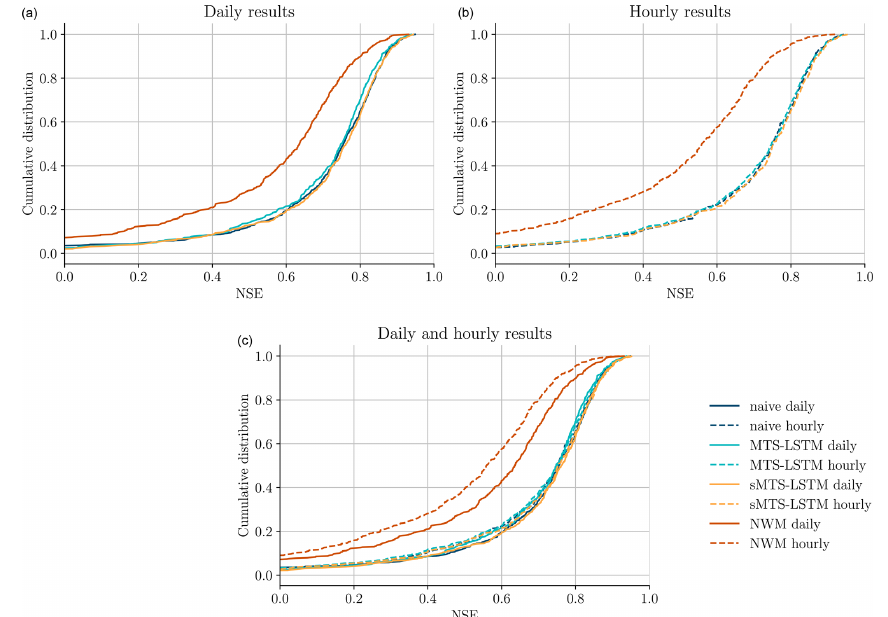
Figure 3. Cumulative NSE distributions of the different models. Panel (a) (solid lines) shows NSEs of daily predictions, panel (b) (dashed lines) shows NSEs of hourly predictions, and panel (c) combines both plots into one for comparison.